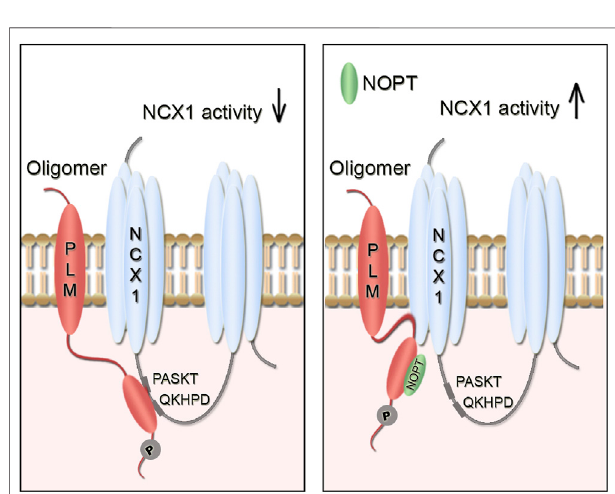
FIGURE5 | Illustration ofthe inhibitory pSer68-PLM-NCX1 interaction in heart and relief of its inhibition by NOPT. (A) Without NOPT, the pSer68-PLM dimer binds to the cytoplasmic part of NCX1 and inhibits NCX1 activity. (B) Binding of NOPT to PLM disrupts the inhibitory pSer68-PLM-NCX1 interaction, leading to increased NCX1 activation. NOPT does not disrupt the physical interaction between the endogenous full length proteins, which is in linewiththatNCX1andPLMmightbeembeddedinlargerPLM-NCX1protein complexes, consisting of NCX1 dimers (Ren et al., 2008; John et al., 2011) and PLM oligomers (Beevers and Kukol, 2006; Bossuyt et al., 2006; Song et al., 2011).It isalso possible thattwo PLM molecules (dimer) bind tothe two PASKT- and QKHPD-motifs in the NCX1 monomer.